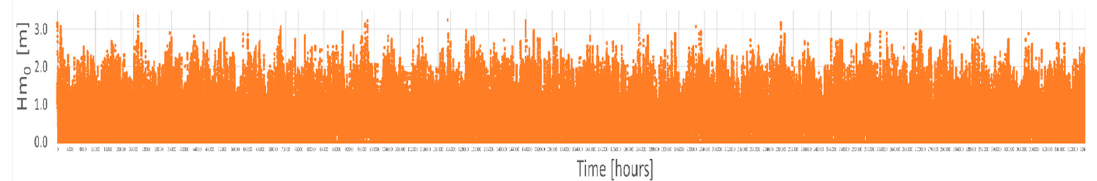
Figure 4. Wave heights in meters from hindcast data, period 01.01.1979 to 31.12.2016. Used only to assess year-by-year variability.